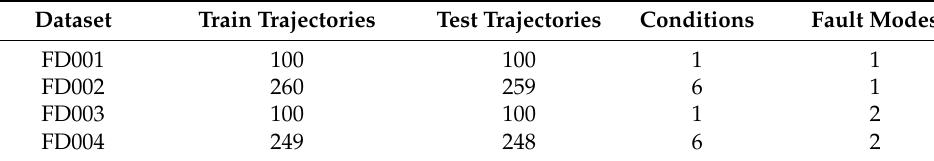
Table 4. C-MAPSS datasets.